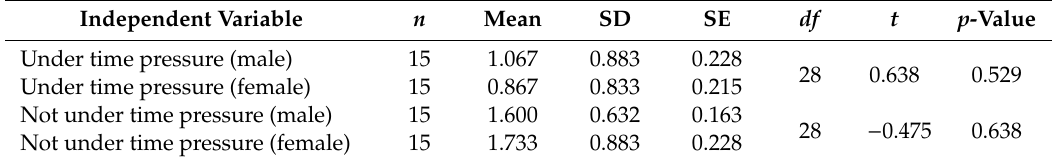
Table 8. Independent t -test results for gender di ff erences in the number of renowned brands. Independent